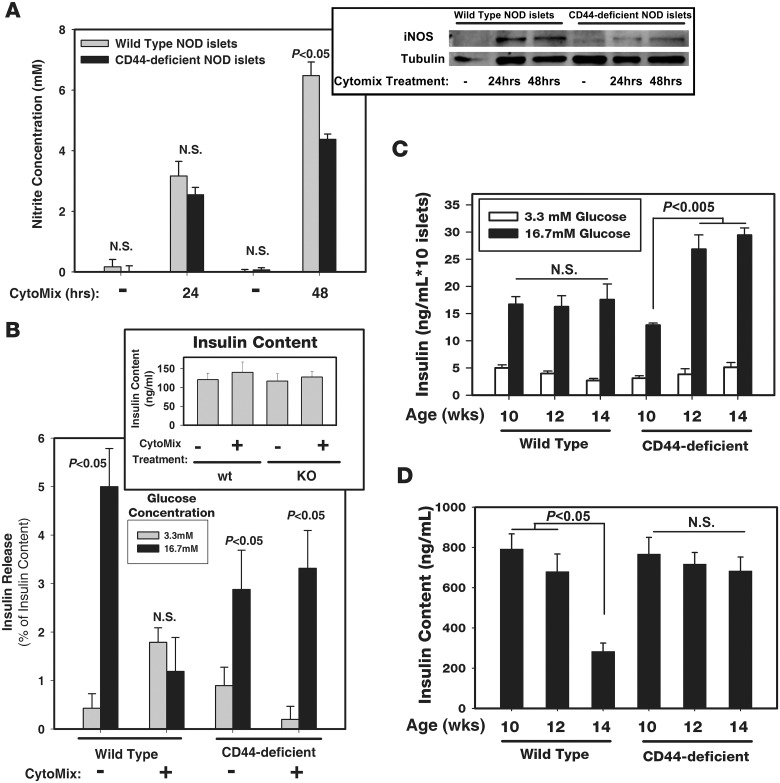
CD44-deficient pancreatic islet cells retain their functionality under pro-inflammatory conditions.(A and B) In vitro pro-inflammatory conditions. A) Griess assay. Wild type and CD44-deficient pancreatic islet cells were incubated with medium (-) or Cytomix for 24 and 48 h. Nitrite release was assessed by Griess assay (n = 3). Inset: Cell extracts from pancreatic islets described in (A) were subjected to Western blot analysis, using anti-iNOS antibody. A representative Fig of three experiments. B) Glucose-stimulated insulin secretion (GSIS). Pancreatic islet cells from WT and CD44-deficient NOD mice were incubated with medium (-) or Cytomix for 48 h and then stimulated with 3.3 or 16.7 mM glucose for additional one hour and their ability to secrete insulin was measured by ELISA. Inset: Insulin content in each one of the samples (n = 4–5) (error bars, SEM). Statistical analysis for A and B by standard two-tailed Student’s t-test. A, one representative experiment of five. B, one representative experiment of two. (C and D) Ex vivo pro-inflammatory conditions. C) Freshly isolated pancreatic islet cells from WT and CD44-deficient pre-diabetic NOD females were processed as described in (B) (n = 6–8) (error bars, SEM). D) Content of insulin in pancreatic islets of WT and CD44-deficient pre-diabetic NOD females was analyzed by ELISA. Statistical analysis in C and D by standard two-tailed Student’s t-test. The statistical analysis in C shows that the ex vivo insulin release of CD44-deficient pancreatic islets at 12 and 14 weeks is significantly higher (p<0.05) than the insulin release of the corresponding WT cells.The statistical analysis in D shows that the insulin content in pancreatic islets of 14 wks-old pre-diabetic WT mice is significantly different (P < 0.05) from all other samples. (n = 6–8). In C—D, at least one representative experiment of two.